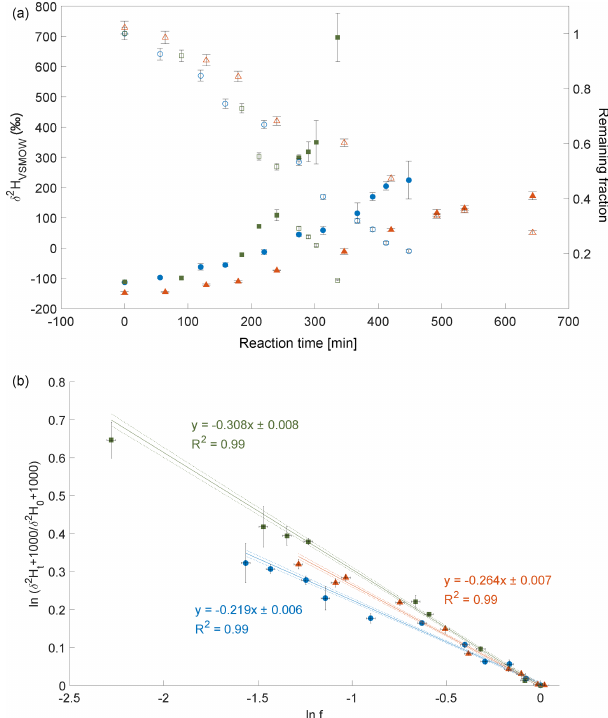
Figure 2. Reaction of CH 3 Cl and OH. Three independent experi- ments (triangles, dots and squares) were carried out using an initial mixing ratio of 5 to 10ppmv CH 3 Cl. More than 70% of the CH 3 Cl was degraded within 6 to 10h. (a) Measured δ 2 H values (filled cir- cles, triangles and squares) of CH 3 Cl versus residual fraction (open circles, triangles and squares) of CH 3 Cl (calculated from changes of CH 3 Cl and PFH). Error bars of δ 2 H value of CH 3 Cl indicate the standard deviation (SD) of the mean of three replicate measure- ments. Some error bars lie within the symbol. (b) Rayleigh plot (Eq. 3). Error bars were calculated by error propagation including uncertainties in δ 2 H values of CH 3 Cl and the remaining fraction. Dashed lines represent 95% confidence intervals of the linear re- gressions (bold